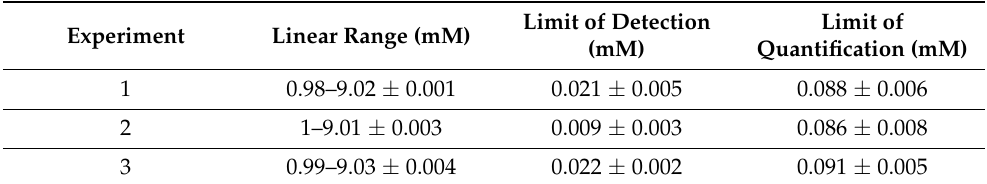
Table 3. Repeatability of proposed NiO nanostructures prepared with 10 mL of bitter gourd peel extract.